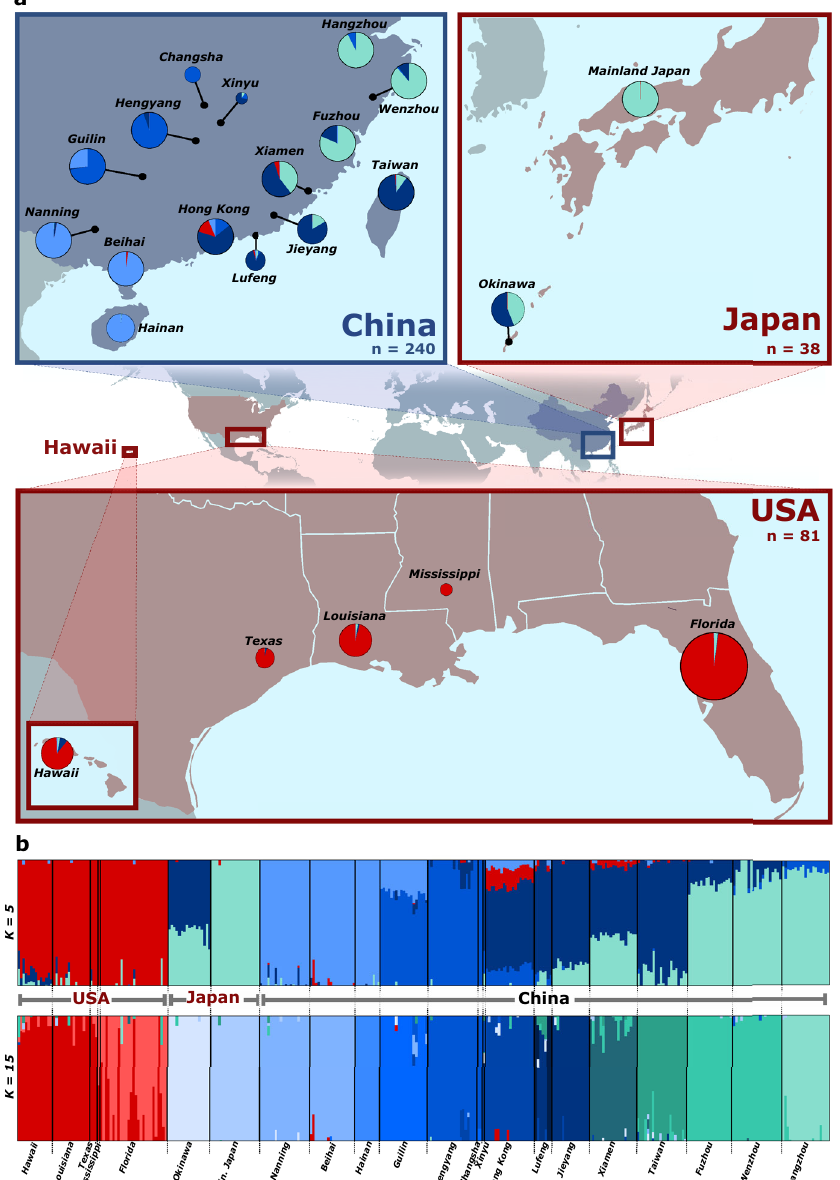
Fig. 1 Genetic clustering of C. formosanus populations. a Pie charts of fastSTRUCTURE assignments (for K = 5) for each sampling location of C. formosanus in its native and introduced range. Pie chart size is proportional to the number of samples. b fastSTRUCTURE assignment for each individual sampled for K = 5 and 15. Each color represents a distinct genetic cluster and each vertical bar represents an